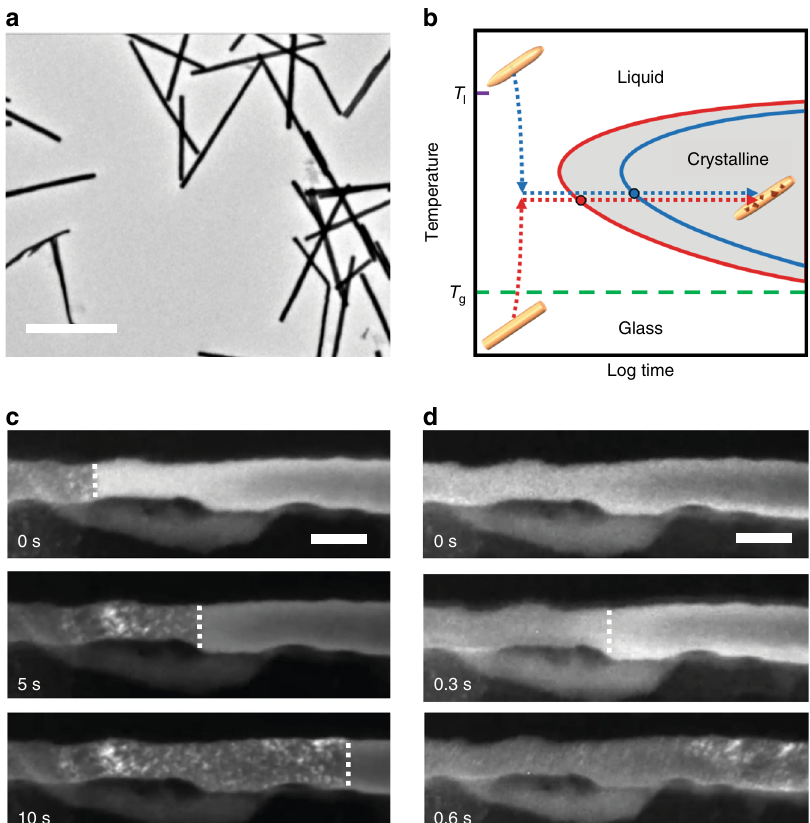
Fig. 1 Asymmetric growth rates of MG nanorod during isothermal crystallization. a Bright- fi eld TEM image of MG nanorods that are drop-cast on a thin ceramic fi lm for in situ TEM experiments. The scale bar is 1 µ m. b Temperature – time sequences used for the isothermal crystallization experiments. The MG nanorods were fi rst rapidly heated to 900 °C for <5 s to remove any residual microstructures that may be left behind from thermoplastic forming. For crystallization from the melt state, the rods were then quenched and held at constant temperature for in situ observations (blue dotted line). For the studies of crystallization from the glass state, the rods were quenched to room temperature, then heated to and held at constant temperature (red dotted line). c , d Snapshot dark fi eld (DF) TEM images of the same nanorod undergoing crystallization from the cooled liquid ( c ) and from the heated glass ( d ). The white dotted lines indicate the growth front, determined by the intensity contrast between the crystalline and amorphous regions. Despite using the same crystallization temperature of 420 °C, the growth rate from the heated glass is much higher than that from the cooled liquid. The scale bar is 80